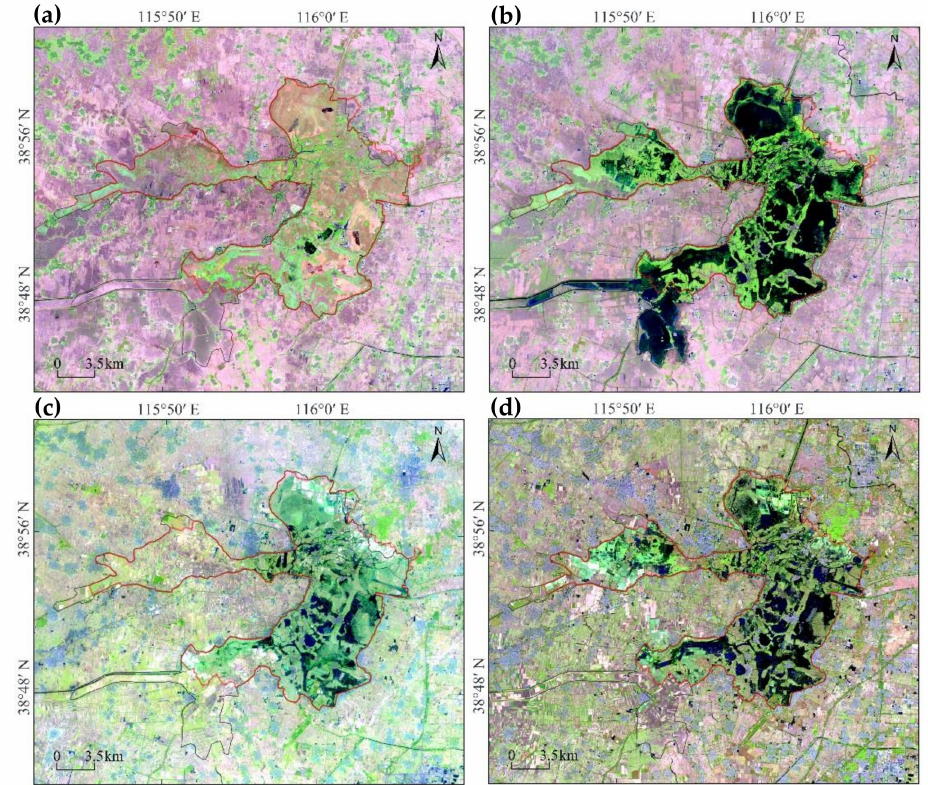
Figure 5. Landsat images of wetland habitat in ( a ) dried up wetland on 19 October 1984; ( b ) a large water extent on 17 October 1989 in the first phase; ( c ) less water extent on 24 October 2009 in the second phase and ( d ) current wetland on 30 October 2017 in the third phase, which are the color composition of RGB, ( a – c ) are from combination of bands 5,4,3 of TM data and ( d ) is bands 6,5,4 of OLI data, respectively. The red polyline and black polyline are the wetland range of 2017 and 1989, delineated by the visual interpretation of Landsat image,